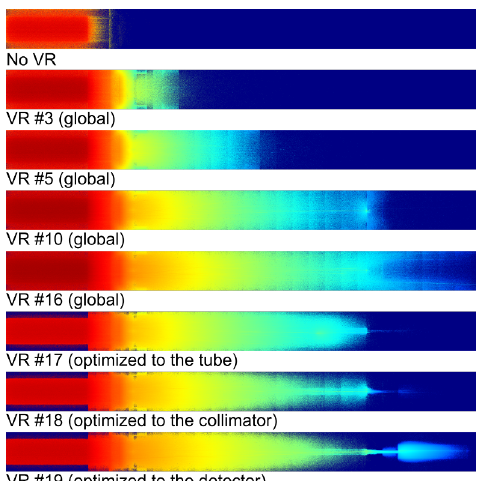
Figure 4: Scores contributing to the overall flux during variance reduction (VR) iteration steps. Serves only as a qualitative